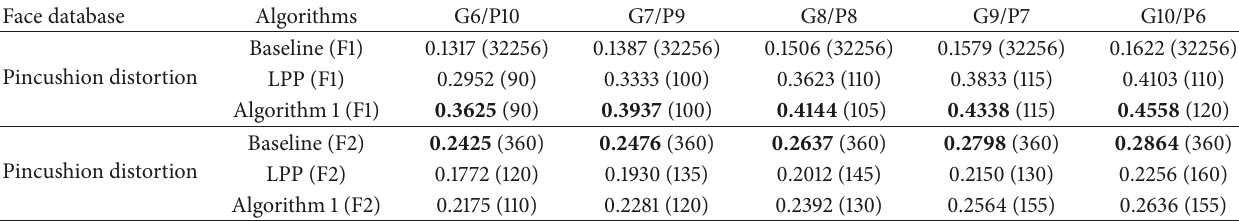
Table 20: The recognition rates on pincushion distortion Extended Yale B face database over “F1” and “F2” features; recognition rates (dimensionality).